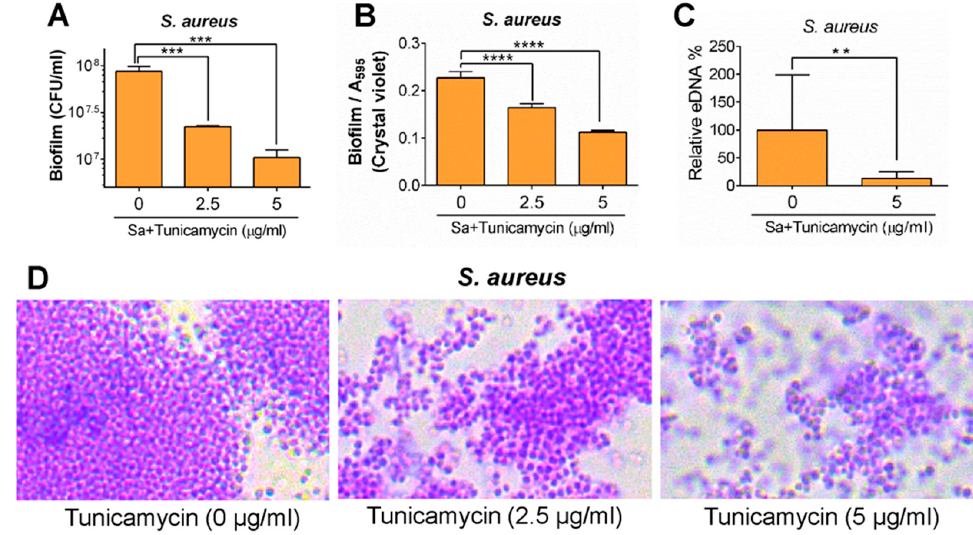
Figure 4. Tunicamycin-mediated inhibition of teichoic acids also suppresses S. aureus biofilm formation in a dose-dependent manner. Upper panels ( A – C ) show a quantitative assessment of biofilm formation (colony counts, crystal violet staining, and eDNA amounts), and lower panel ( D ) shows crystal violet-stained S. aureus cells in biofilms in the presence of variable concentrations of tunicamycin. The figure was adapted with permission from Zhu et al. 2018 [77]. ****, p < 0.0001; ***, p < 0.001; **, p < 0.01.